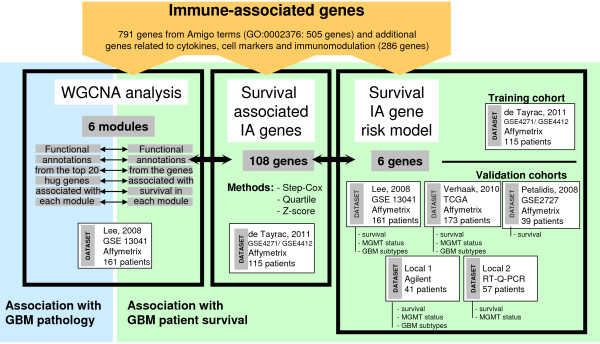
Analysis workflow. 791 IA genes were studied in three analyses: weighted gene co-expression network analysis (WGCNA) and functional annotation were performed on the GSE13041 data set (blue box); 108 survival associated IA genes were found by 3 different methods (Step-Cox, Quartile, Z-score) on de Tayrac dataset (middle green box); survival IA gene risk model was built on de Tayrac dataset and validated on 5 datasets: GSE 13041, TCGA, GSE2727, a local Agilent dataset, a local RT-Q- PCR dataset (right hand-side green box).